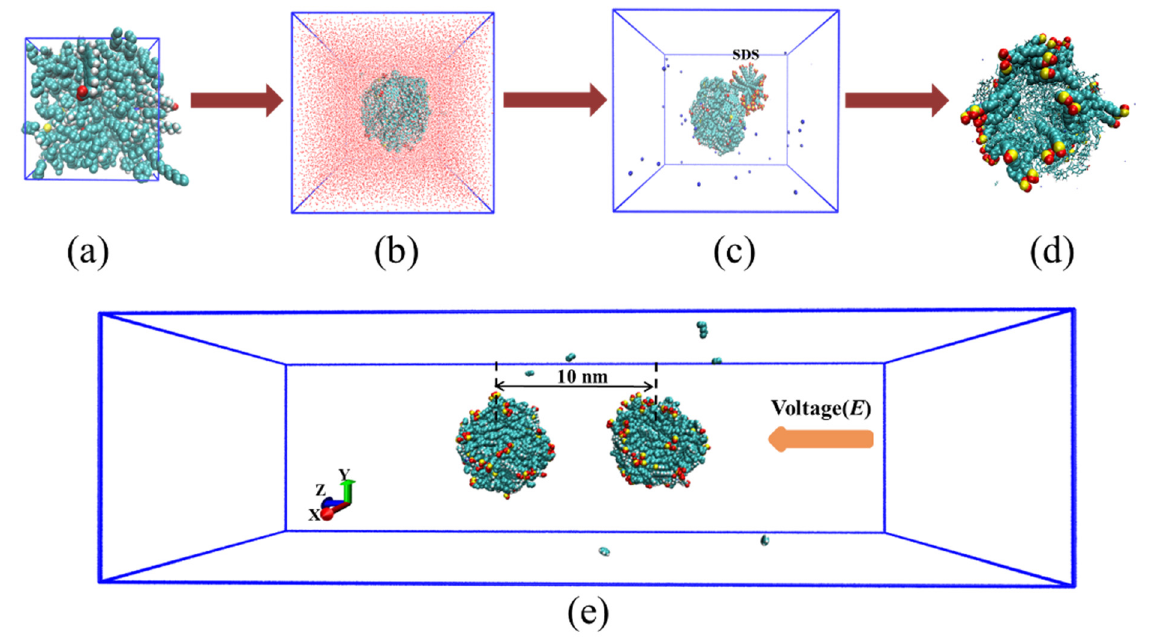
Figure 11. Schematic diagram of the building of emulsified oil droplet. ( a ) Equilibrium configuration of bulk crude oil after NPT simulation, ( b ) emulsified oil droplet in water, ( c ) initial configuration of emulsified oil droplet and SDS micelle, ( d ) Equilibrium configuration of emulsified oil droplet with SDS. For clarity, water molecules in ( c , d ) were not shown. ( e ) Lateral view of model simulation for the movement and aggregation behavior of oil droplets in O/W emulsion under BPEF. For clarity, water molecules in the system were not shown.